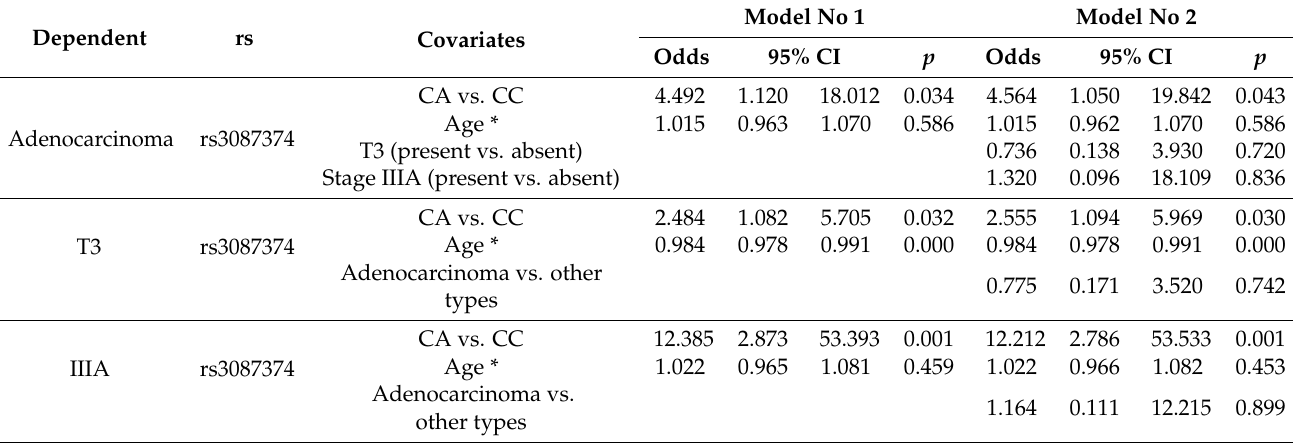
* Age at the time of diagnosis. T3, size of primary tumor according to TNM classification. IIIA, stage IIIA of cervical cancer. Model No. 1, the logistic regression analysis adjusted for age at diagnosis. Model No. 2, the logistic regression analysis adjusted for age at diagnosis and selected parameters. CI, confidence interval.